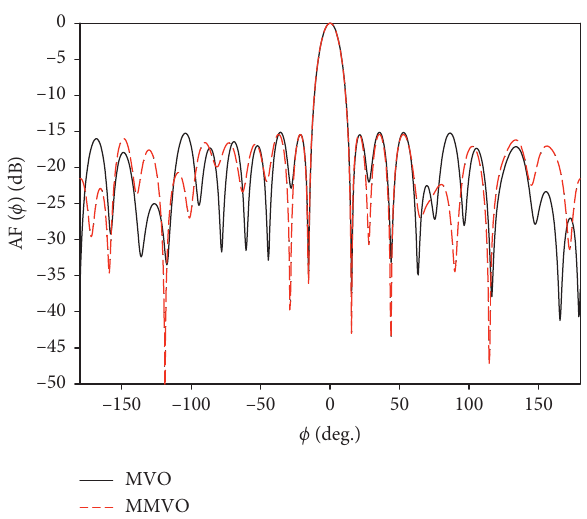
Figure 7: Radiation pattern of the optimized 20-element CAA.